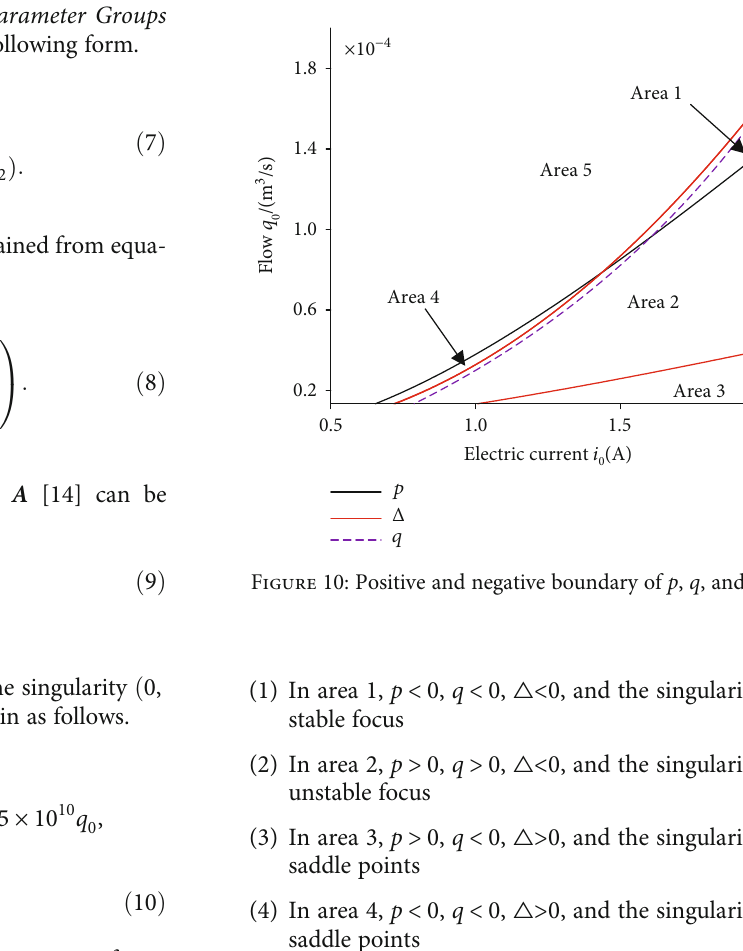
Figure 9: Positive and negative boundary of p , q , and △ .